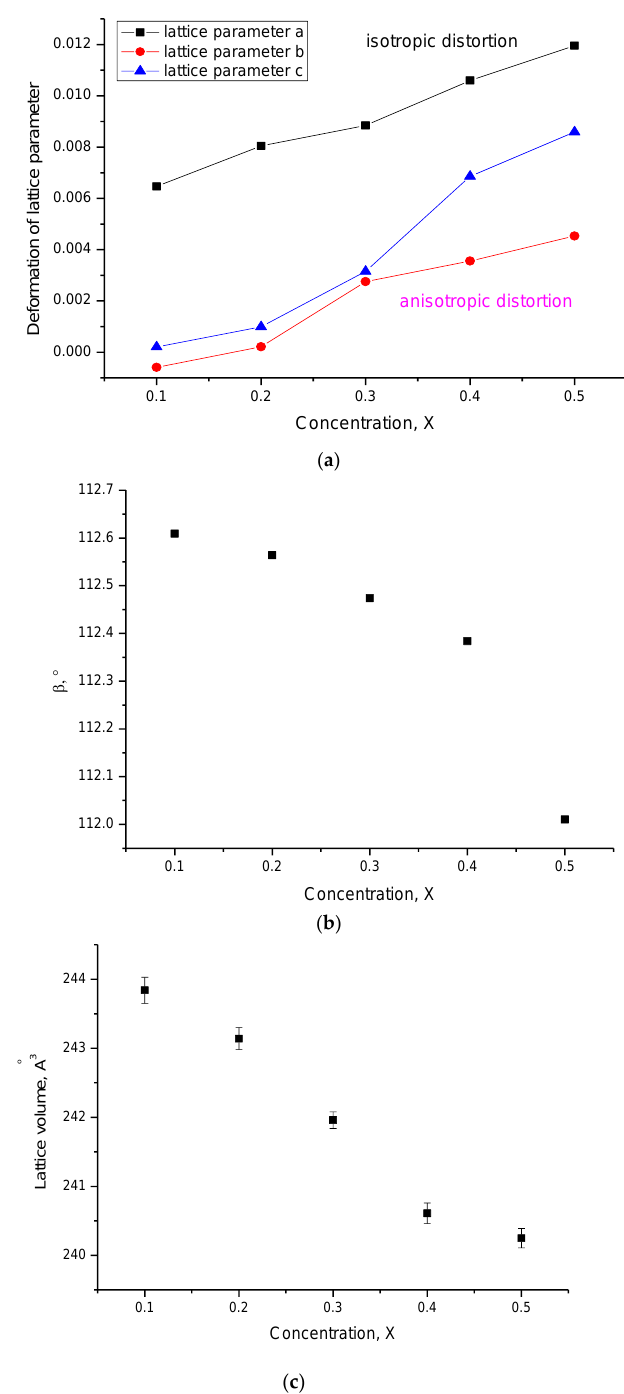
Figure 3. ( a ) Results of crystal lattice deformation; ( b ) results of beta angle deformation; ( c ) results of crystal lattice volume deformation. The results of changes in the structural parameters (Figure 3) for high annealing temperatures are in good agreement with the results in [34], according to which, at high annealing temperatures, an anisotropic change in the crystal lattice parameters was ob- served due to thermal effects, as well as the difference in cationic radii. In this case, changes in the parameter a depending on the content of the component have an isotropic nature of distortions, while the parameters b and c change anisotropically, which may be due to the difference in the filling of lattice sites, as well as inhomogeneity in the re- placement of zirconium ions by lithium ions. A decrease in the crystal lattice parameters, as is known, leads to a decrease in its volume and, consequently, to a decrease in porosity and an increase in the density of ceramics. Figure 4 shows the results of changes in the density and porosity of the ceram- ics depending on the X component concentration. A change in density, including its de- crease at high annealing temperatures of 1500 °C, is due to the fact that with a change in the components used for synthesis, by varying them with a subsequent increase in LiClO 4 ·3H 2 O, the crystal lattice volume decreases, which leads to ceramic compaction. At the same time, the difference from the density values presented in [28], which are close to the theoretical values, is that, at high lithium concentrations, there is an overall increase in the lattice volume, which leads to lower ceramic density values. As can be seen from the data presented, a change in the crystal lattice parameters leads to the compaction of ceramics, as well as the approximation of the experimentally obtained density values to the theoretical value (95 – 97%). In this case, porosity decreases from 4.1% to 2.6%, with an increase in the X component, which, in turn, results in the ceramics strengthening to mechanical stress. Figure 5 shows the measurement results of th e ceramics’ single compression re- sistance. The change in the resistance value depending on the concentration of X varies in the range from 29.3 to 38.4 N, while for concentrations X = 0.4 – 0.5, an increase in re- sistance of 25 – 30% is observed. Such an increase in single compression resistance is due to an increase in the density of the ceramics, as well as a change in the dislocation den- sity, which leads to a strengthening effect and an increase in fracture resistance. A com- parative analysis with the known literature data on measurements of resistance to single compression, taken from [20,35,36], indicated that the synthesized ceramics have an in- creased resistance to mechanical stress, as well as greater strength. At the same time, as shown in [30], in which the properties of two-component Li 4 SiO 4 -Li 2 ZrO 3 ceramics were